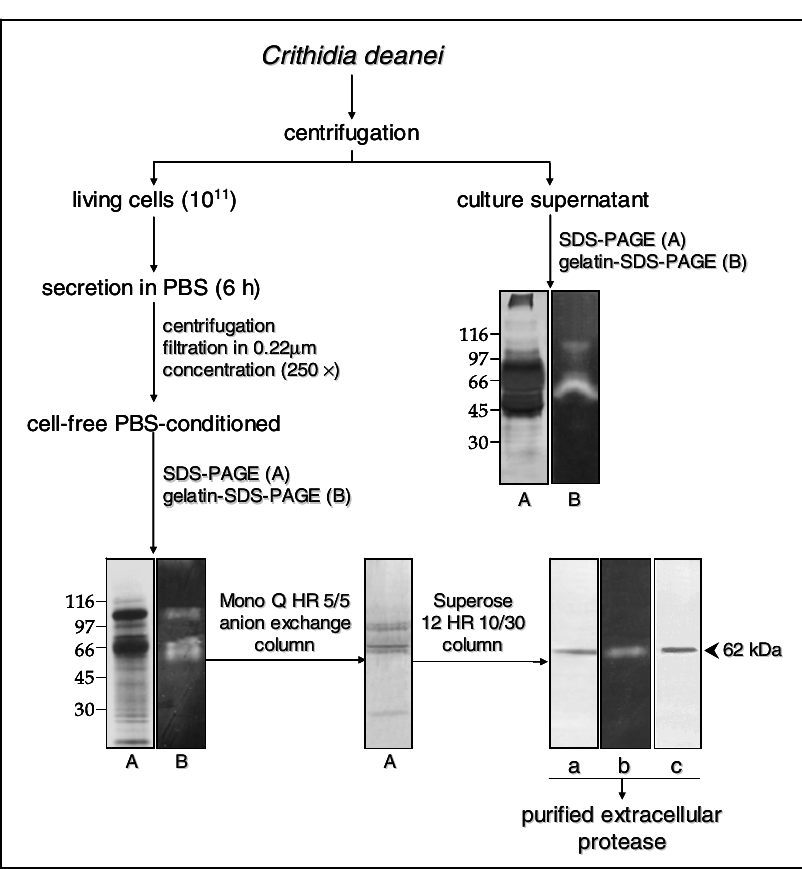
Fig. 4 – Scheme of the strategy employed for the purification of a gp63-like extracellular protease from Crithidia deanei (aposymbiotic strain) (d’Avila-Levy et al. 2003). The comparison of the protein ( A ) and proteolytic ( B ) profiles of secreted polypeptides from the spent culture medium supernatant and from the supernatant obtained from secretion in phosphate buffered saline (PBS) shows that the latter eliminates some major protein contaminants, without significant alteration in the proteolytic profile. For purification, parasites (10 11 cells) were incubated in 1000 mL of PBS for 6 h at 28 ◦ C and the cell-free PBS-conditioned supernatant was concentrated 250 times by ultrafiltration. The chromatographic separations were done using a fast-performance liquid chromatography (FPLC) coupled to anionic and gel filtration columns. The protein purity was shown by SDS-PAGE ( a ), the remaining activity demonstrated by gelatin- SDS-PAGE ( b ) and the homology to gp63 verified by Western blotting using anti-gp63 polyclonal antibodies (Chang and Chang 1986) ( c ). The numbers on the left indicate the position of the molecular mass standards. For experimental details see d’Avila-Levy et al.